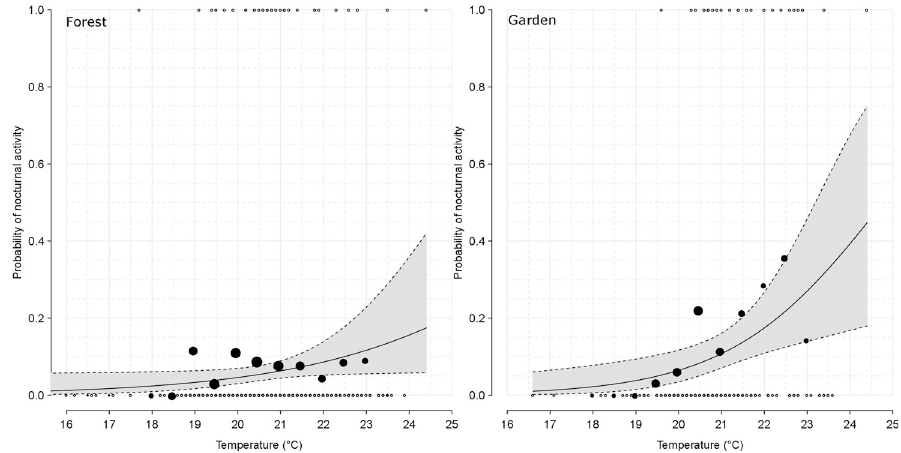
Fig 4. Influence of temperature (˚C) on the probability of observing nocturnal activity by camera traps in chimpanzees from Kibale National Park, Uganda according to the habitat (forest or fields). Left is forest and right is field habitat. Points represent the raw data either under binary form (white points) or averaged (black points). The plain black line depicts the response of the model. It depicts the influence of the temperature while averaging the effects of all other variables. Namely, continuous z-transformed variables were set to 0, while categorical predictor habitat type was dummy coded and z-transformed, and finally also set to 0. The gray polygon indicates the 95% confidence interval, borders are depicted by the black dashed